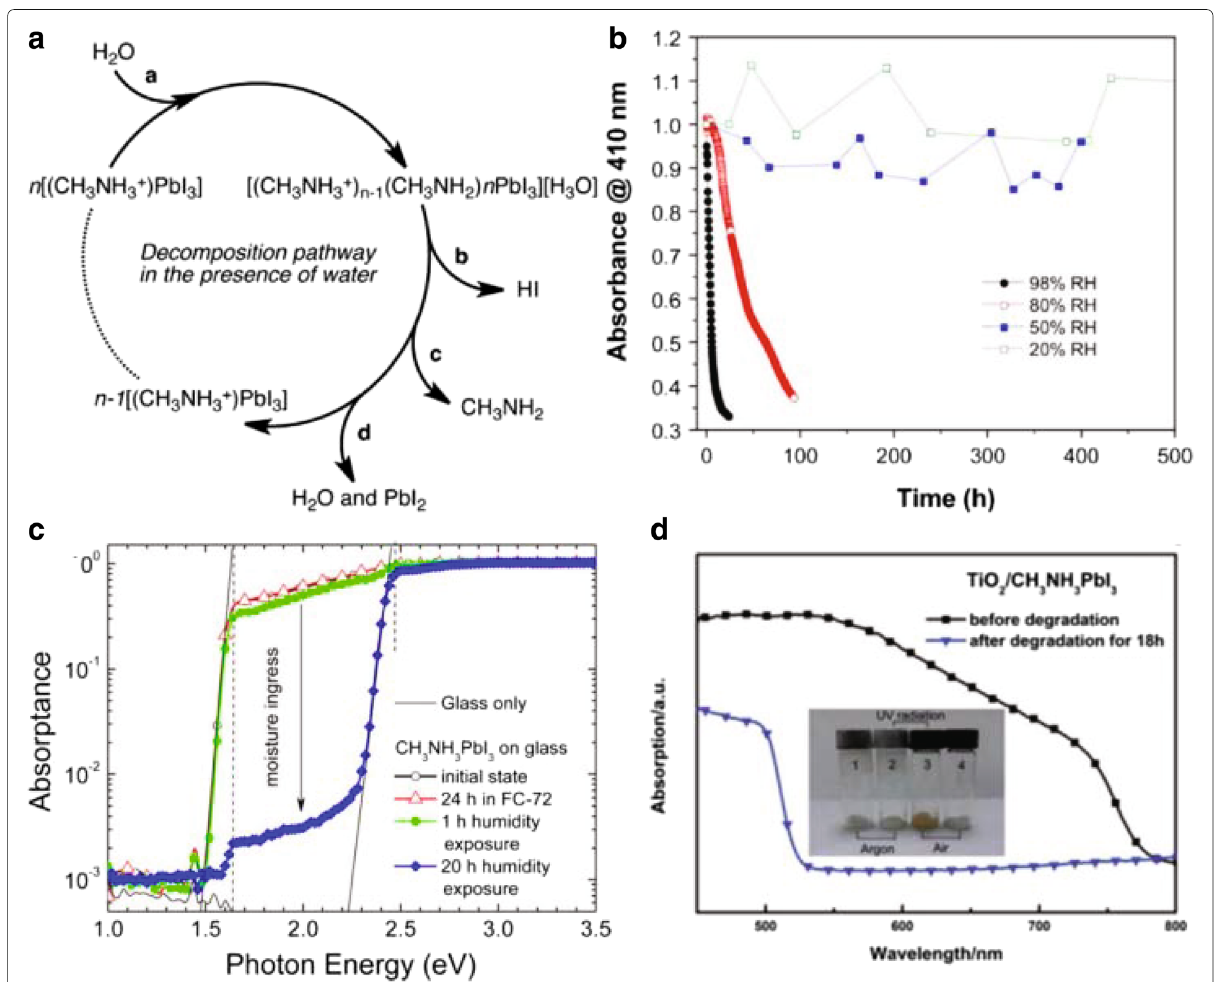
Fig. 6 a Proposed decomposition pathway of CH 3 NH 3 PbI 3 in the presence of a water molecule. The main product of this pathway is PbI 2 [48]. b Normalized absorbance measurements (taken at 410 nm) for CH 3 NH 3 PbI 3 films exposed to different relative humidity [49]. c PDS spectra for CH 3 NH 3 PbI 3 films before (initial state) and after exposure to a relative humidity in the range of 30–40% for different times. This clearly indicates a significant reduction in absorption in the range of 1.5–2.5 eV after exposure to humidity [1]. d Degradation of CH 3 NH 3 PbI 3 in moisture and air atmosphere. UV-vis absorption spectra of TiO 2 /CH 3 NH 3 PbI 3 film before and after degradation. The inset is a photograph of CH3NH3I exposed to different conditions: (1) CH 3 NH 3 I exposed to argon and without UV radiation; (2) CH 3 NH 3 I exposed to argon and with UV radiation; (3) CH 3 NH 3 I exposed to air and with UV radiation; and (4) CH 3 NH 3 I exposed to air and without UV radiation